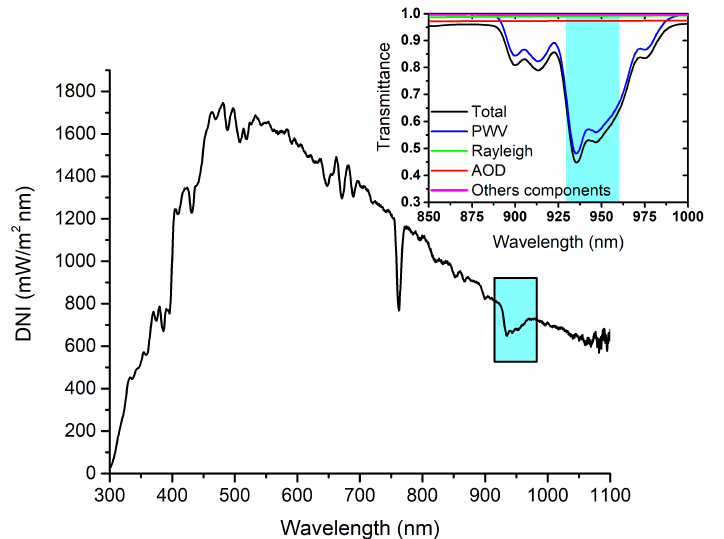
Figure 1. Direct normal irradiance, DNI ( λ ), performed with the EKO MS-711 spectroradiometer on 20 May 2019 (13:00 UTC) at IZO. The blue box indicates the water vapor absorption band selected in this work for the PWV retrievals (930–960 nm). The zoomed graphic shows the direct transmittance simulated with MODTRAN model between 850 and 1000 nm on 20 May 2019 (13:00